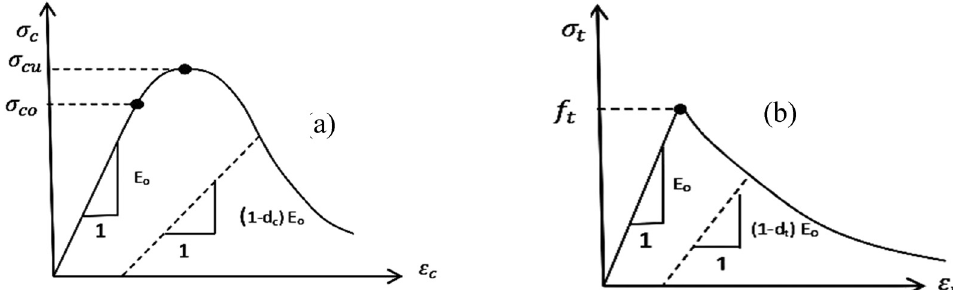
Figure 1: Response of concrete: ( a ) uniaxial compression and ( b ) uniaxial